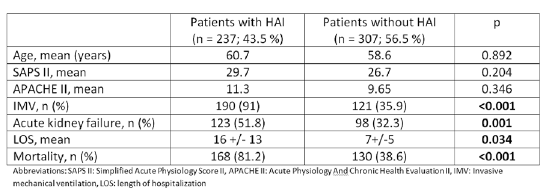
Table 1: Comparison of clinical and outcome findings between HAI and non-HAI